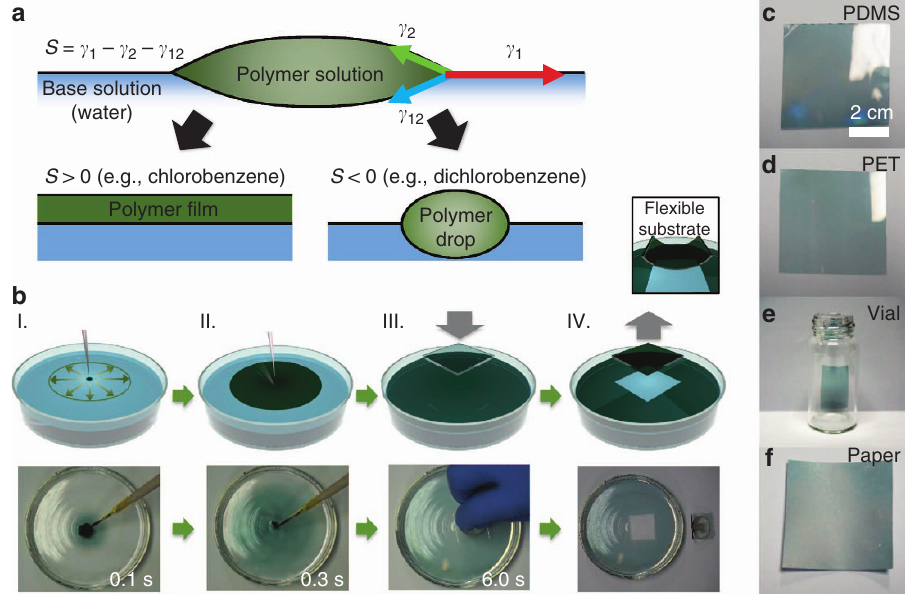
Figure 1 | Principle and formation process of spontaneous spreading. ( a ) Spreading of polymer solution dropped onto the base solution is determined by the spreading coefficient, S . Positive S results in a uniform polymer film; otherwise, polymer drops aggregate; ( b ) Schematic illustrations of formation of an SS BHJ film on water and transfer to target substrates. Actual processing images are shown. ( c – f ) Transferred SS-PTB7:PC 71 BM films on various substrates: PDMS ( c ), PET ( d ), copy paper ( e ) and a curved surface of a vial ( f